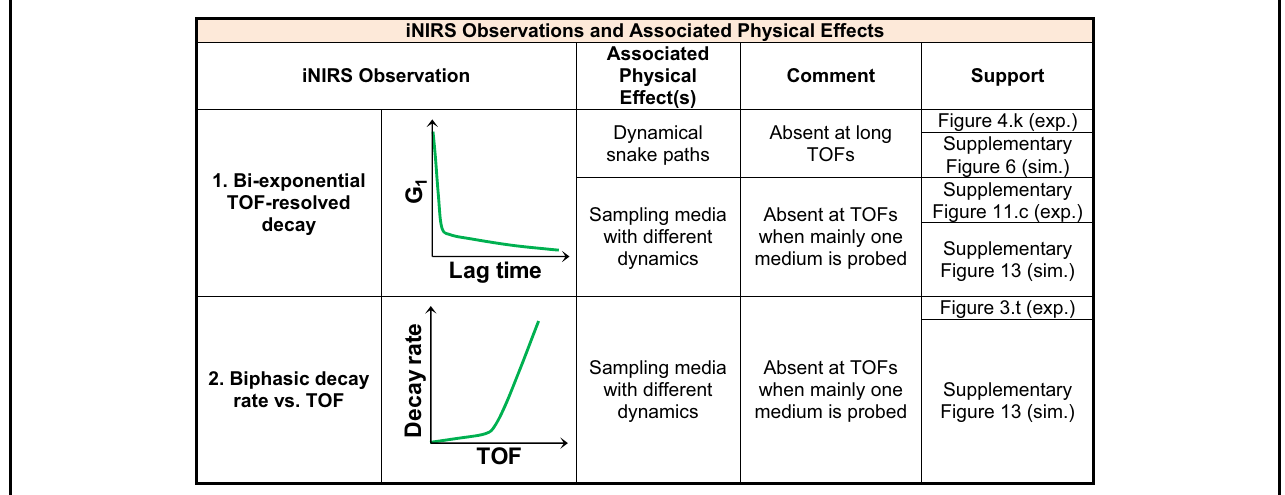
Table 1 Physical effects leading to iNIRS observations. Based on in vivo iNIRS data and simulations, we ascribe distinct physical effects to salient iNIRS observations. Support for the ascription of physical effects to iNIRS observations is provided in the form of simulation (sim.) and experiment